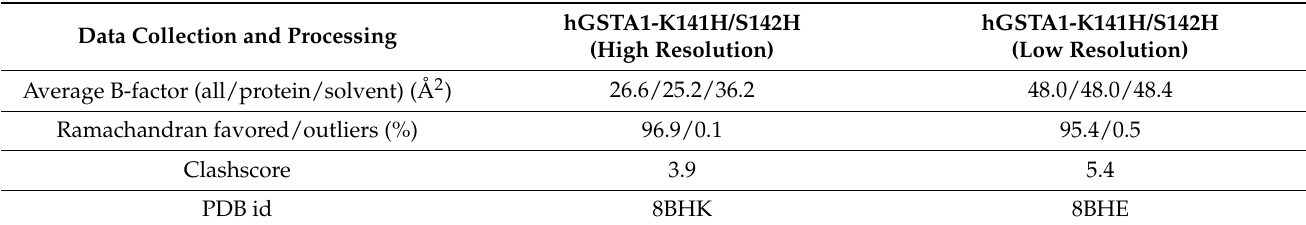
Figure 7. ( A ) Representation of hGSTA1-K141H/S142H subunit. Helices and strands are shown in cyan and magenta, respectively. The helices are labeled. ( B ) Representation of hGSTA1- K141H/S142H dimer from the top. The two-fold axis that relates the two molecules is perpendicular to the plane of the paper. The histidine amino acids at positions 141 and 142 are shown as yellow spheres. The figures were created using PyMOL Molecular Graphics System [30].